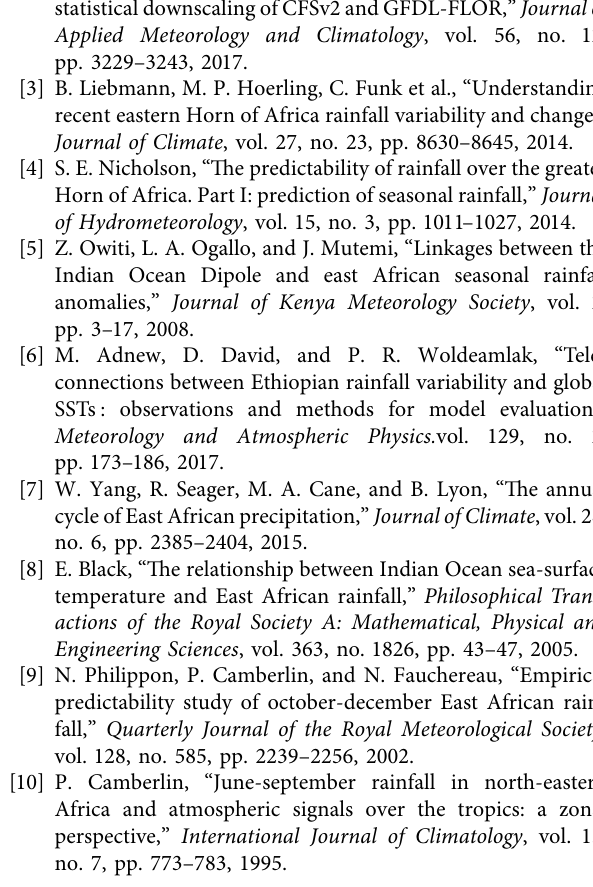
Figure 16: Schematic diagrams showing the relationship of (a) JJAS rainfall and (b) OND rainfall in the GHA with tropical SST. The solid (blank) arrow represents anomalous (climatological) wind at 850hPa. R+ (R-) marks the positive (negative) rainfall anomalies over the